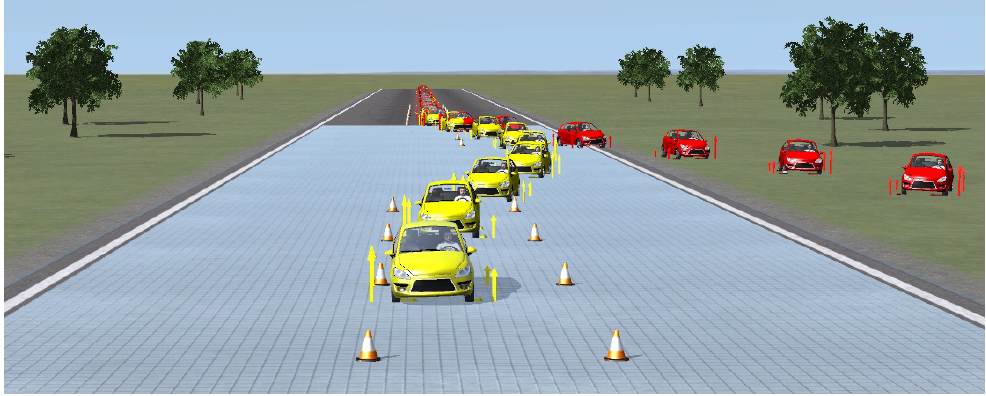
Figure 8. CarSim ® DLC maneuver: open–loop vehicle (red), closed–loop vehicle